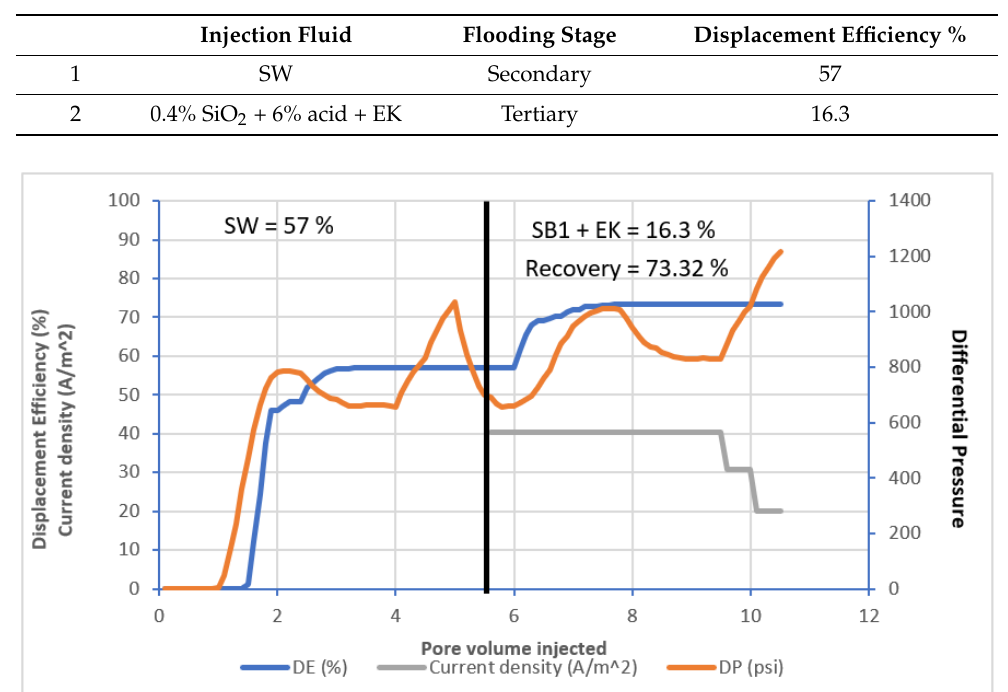
Figure 10. DE, DP ( ∆ P), Current Density vs. Pore Volume Injected for Figure 10. DE, DP (ΔP), Current Density vs. Pore Volume Injected for CF8 .